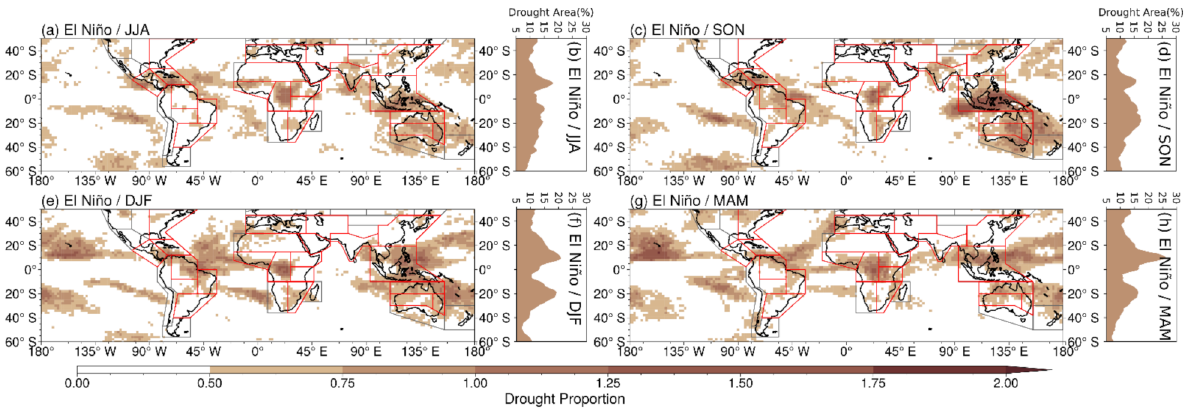
Figure 4. The drought proportion in all seasons from 1951–2020 when El Niño events occur. ( a , c , e , g ) represent the drought proportion in Jun-Jul-Aug (JJA), Sep-Oct-Nov (SON), Dec-Jan-Feb (DJF) of the current year, and March-April-May (MAM) of the following year. ( b , d , f , h ) represent the percentage of drought areas at different latitudes. The land regions with red edges are easily affected by ENSO. The easily-affected regions are where the yellow areas in Figure 1 and the areas with high drought proportion in Figure 4